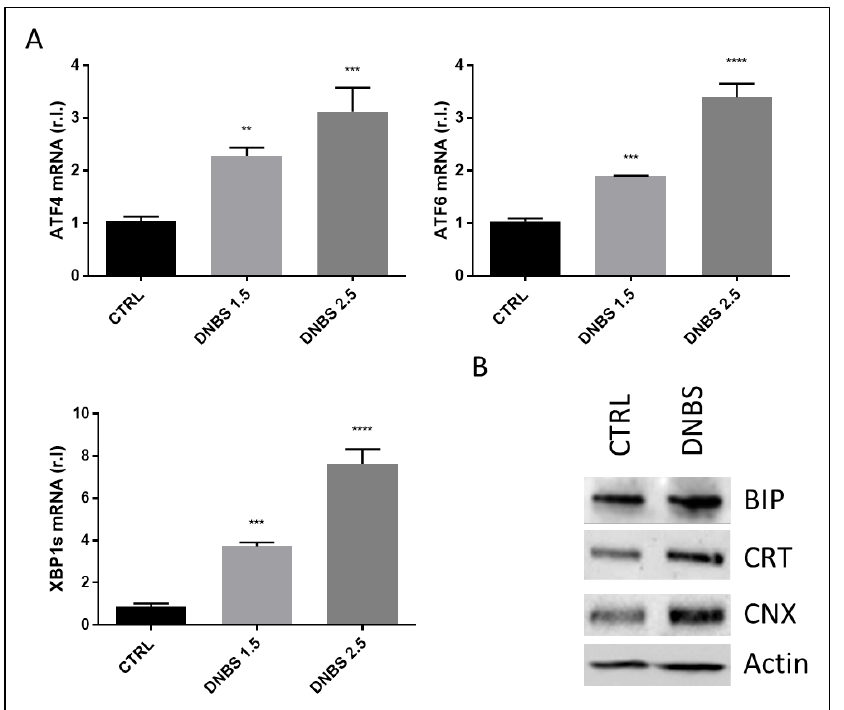
Figure 3. ER Stress induced by DNBS. Colon from C57BL/6 was cultivated for 5 h in a GEVS and untreated (CTRL) or treated with the indicated concentrations of DNBS and the expression levels of the ER stress markers ATF4, ATF6 or XBP1 were evaluated by qPCR ( A ). In parallel, the expression of BIP/Grp78, Calreticulin (CRT) and Calnexin (CNX) was evaluated by western blotting analysis in tissues exposed to 1.5 mg/mL DNBS or vehicle control (CTRL) ( B ). Each panel is representative of experiments performed in triplicate. Histograms represent mean ± SD of triplicate sample; **** p < 0.0001; *** p < 0.001; ** p < 0.01. Actin was used as loading